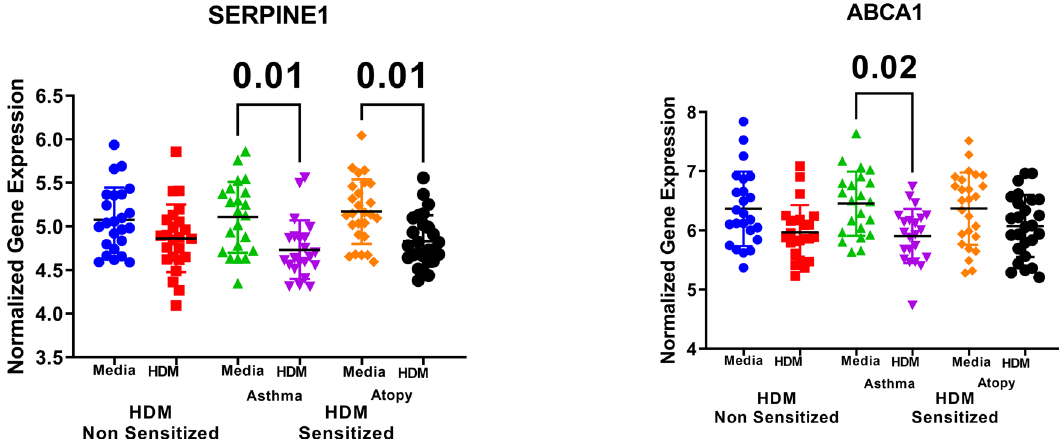
Figure 8. Normalized gene expression of genes identified in CD4 lymphocytes stimulated with HDM compared to media stimulation only in healthy, atopic, and asthmatic patients extracted from the expression profile of publicly available datasets